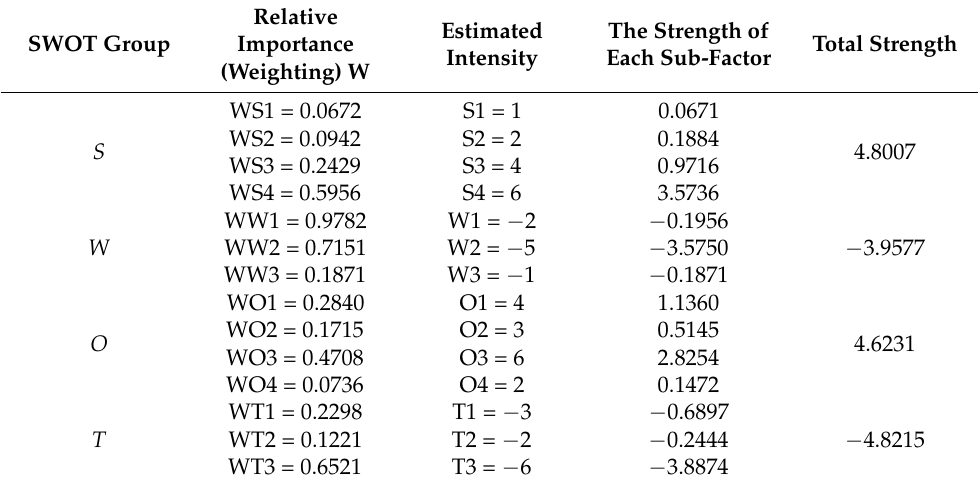
Table 10. The strength of each sub-factor of the